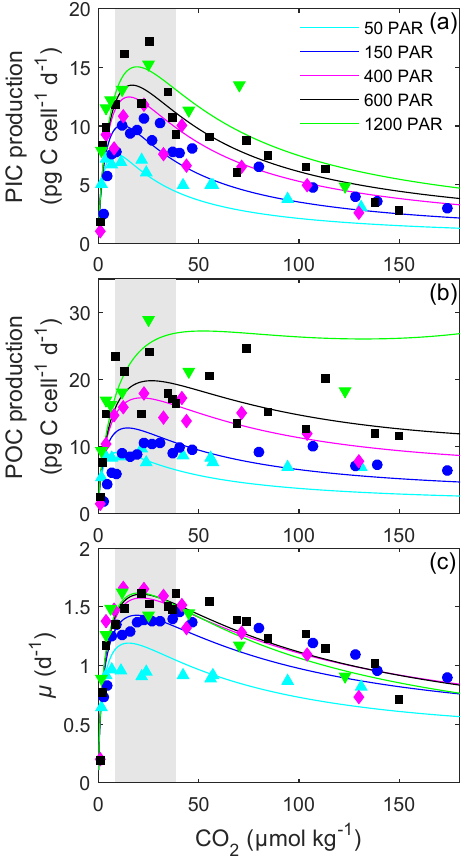
Figure 2. Fitted (solid lines) and measured (symbols) (a) PIC and (b) POC production and (c) growth rates of E. huxleyi in response to changes in CO 2 concentration at six different light intensities using Eq. (2) and fit coefficients from Table 1. Symbols represent rate measurements from this paper at a constant temperature (20 ◦ C) and 50, 150, 400, 600 and 1200µmolphotonsm − 2 s − 1 . Shaded areas represent modern ocean CO 2 concentrations of 8.5–30µmolkg − 1 based on data from Takahashi et al.